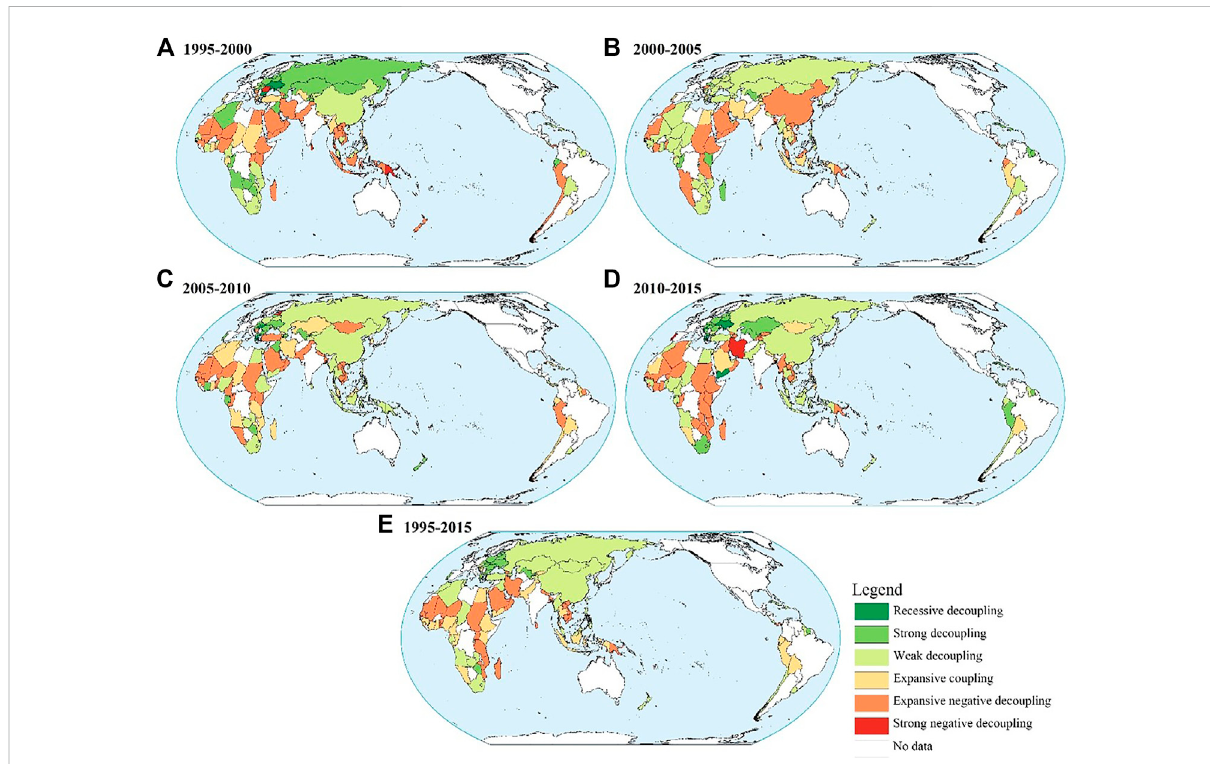
FIGURE 4 Production-based carbon emission decoupling statuses of the Belt and Road